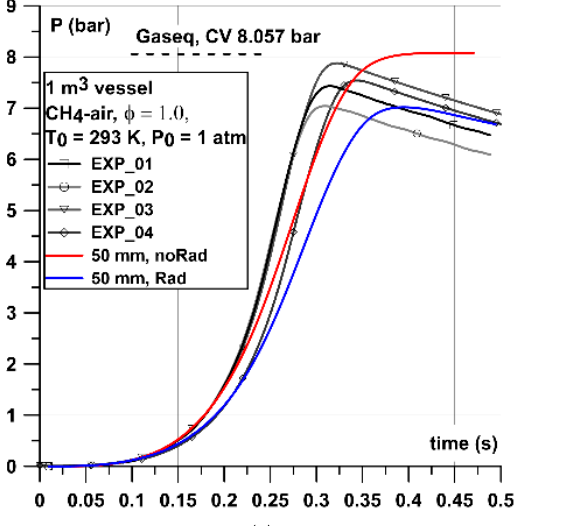
3 vessel. 4 –air mixture in the 0.02 m